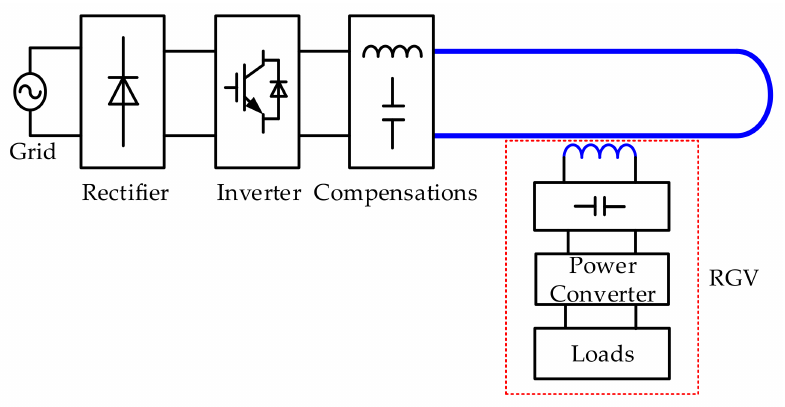
Figure 1. Industrial Rail Guide Vehicles (RGV) inductive power transfer